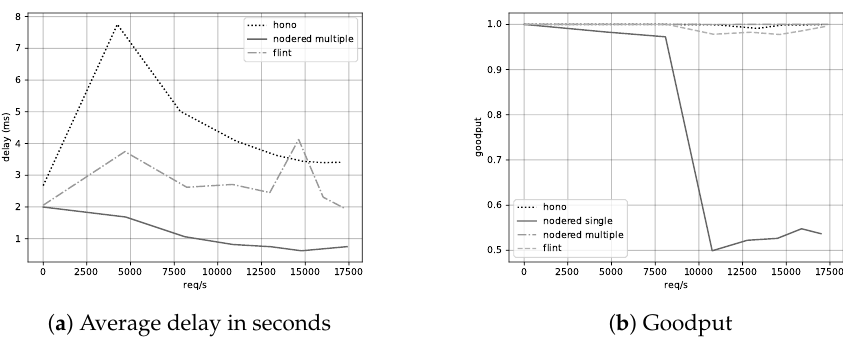
Figure 10. The latency (in seconds) and goodput measured for six MQTT adapters in different platforms. Multiple instances of Node-RED perform best compared to Hono and FLINT. Node-RED single had too large delays for the Figure, but can be retrieved from Table